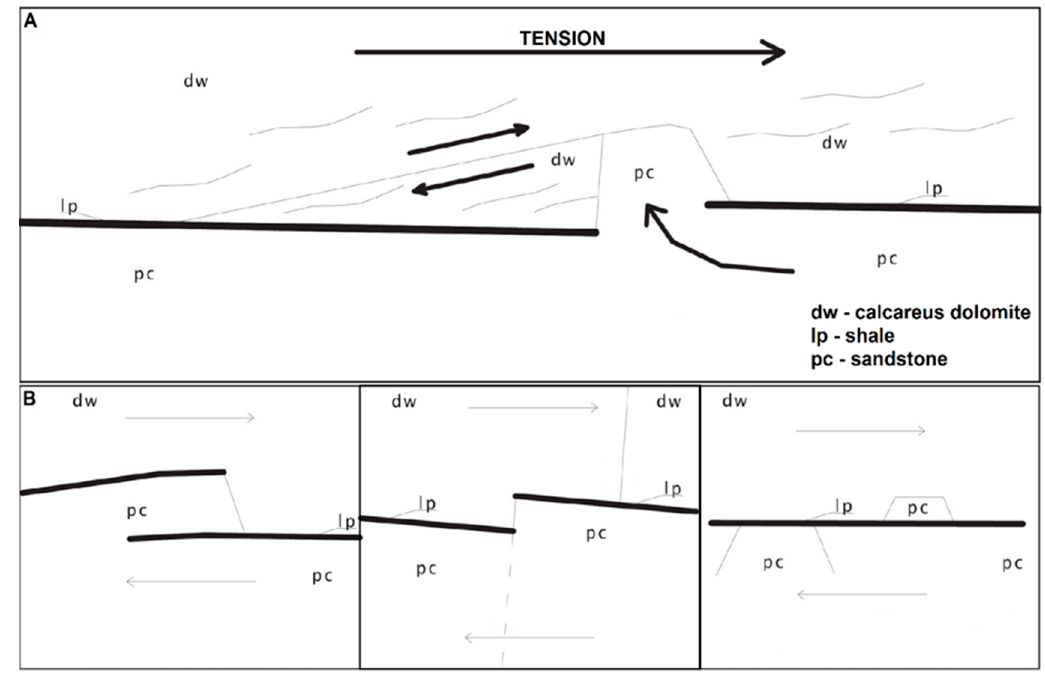
Figure 4. ( A ) Origin of the xenolith and tectonic horst; ( B ) examples of horizontal deformations in tectonic structures, according to [24].